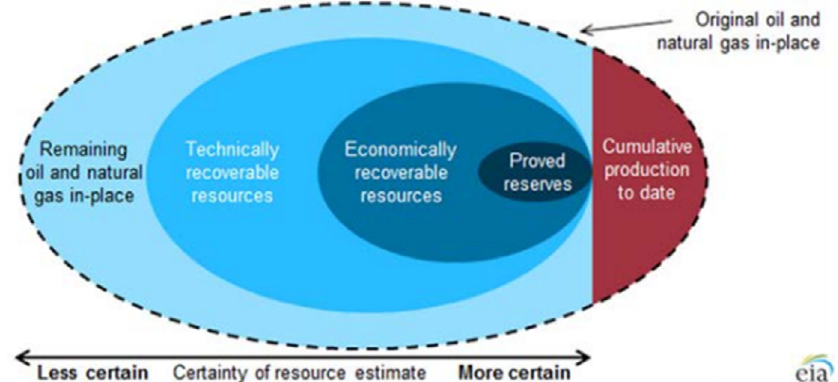
Fig. 2. Natural gas resource types (Energy Information